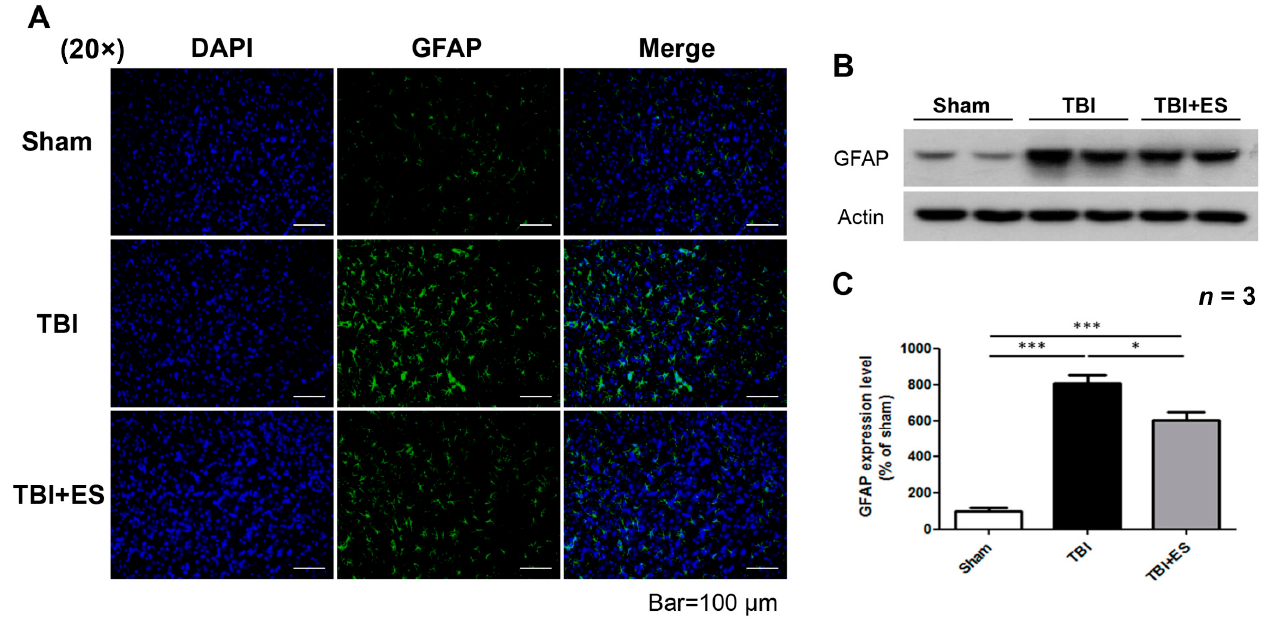
Figure 5. CES decreased the expression of Glial fibrillary acidic protein (GFAP) in the perilesional cortex. ( A ) Representative fluorescence images of GFAP (green), DAPI (blue), and merged picture. ( B ) Representative pictures of western blot for GFAP. ( C ) Quantitative analysis of western blot showed significantly decreased GFAP expression in the TBI + ES group compared to the TBI group. Values are expressed as the mean ± SEM. * p < 0.05, *** p < 0.001.